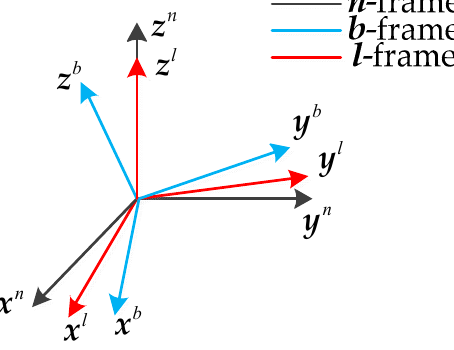
Figure 1. Sketch of the coordinate systems.